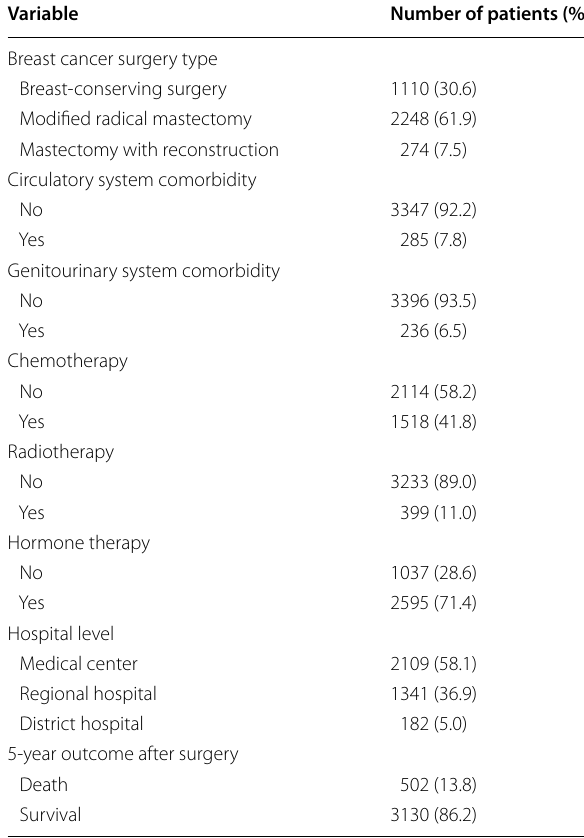
Table 1 Clinical and hospitalization characteristics of the 3632 selected patients who underwent surgery for breast cancer Variable Number of patients (%) Breast cancer surgery